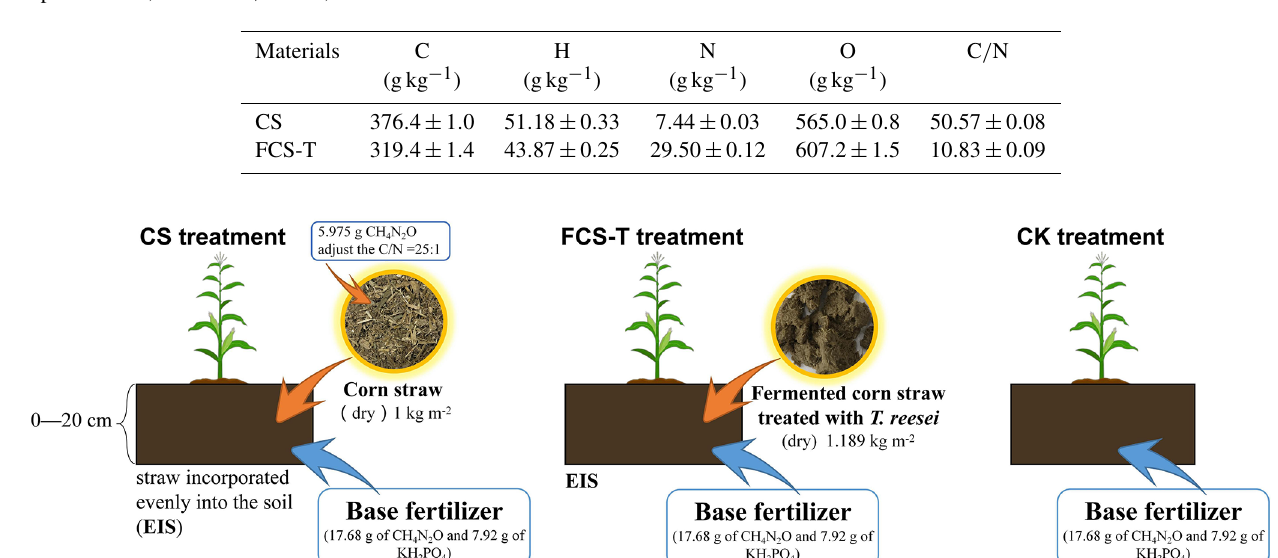
Table 2. Elemental composition of materials used in field experiments. Note that values ( ± standard deviation) were averaged over three replicates. CS, corn straw; FCS-T, fermented corn straw treated with T. reesei .